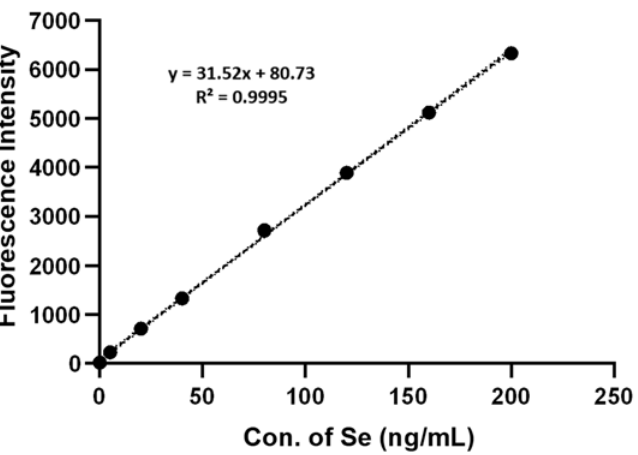
Figure 8. Selenium Standard Curve determined by